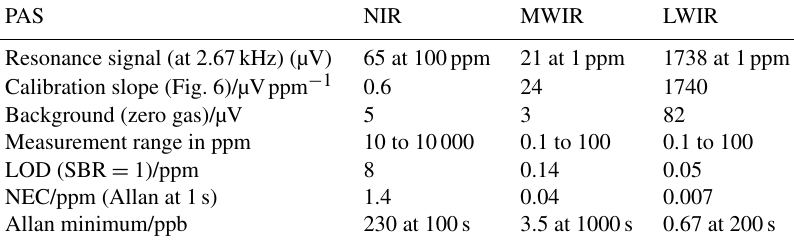
Table 5. Results of the PAS